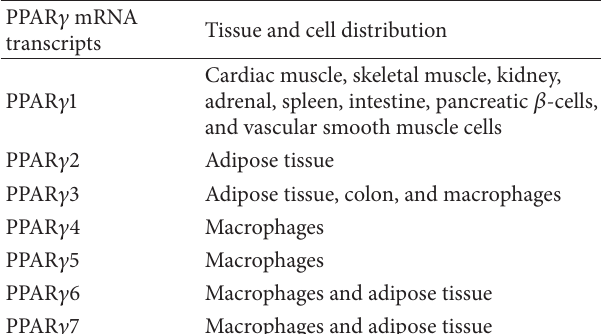
Table 1: Tissue and cell distribution of PPAR 𝛾 mRNA transcripts. Modified from